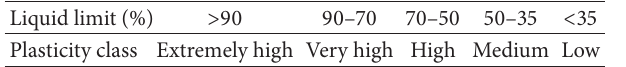
Table 1: Classification of the plasticity of soils according to ˇCSN Standard 2003